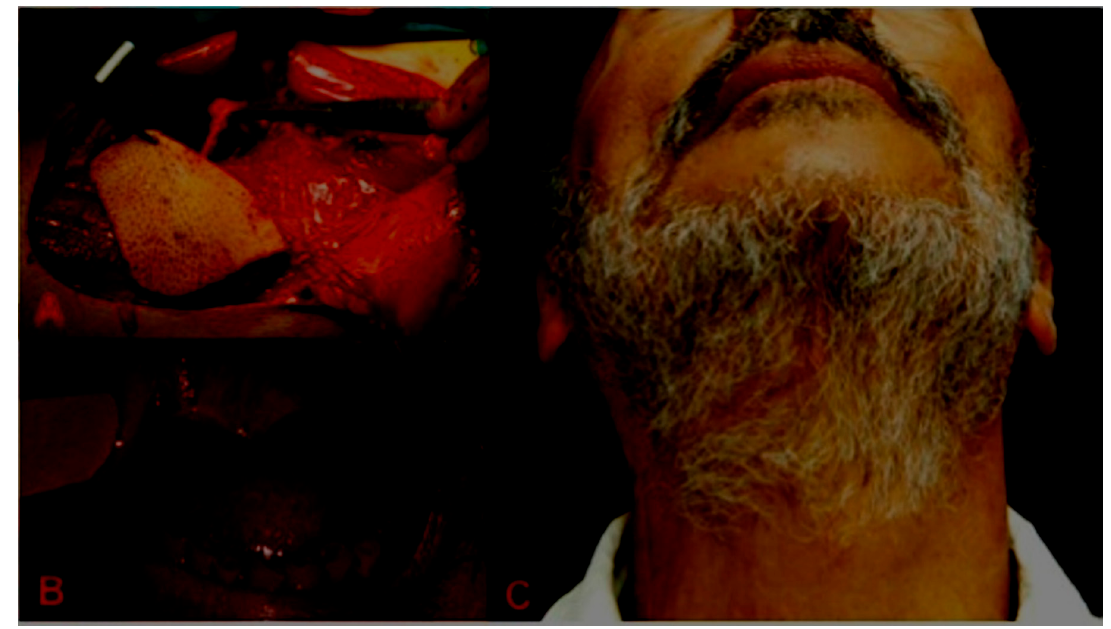
Figure 2. Case 1: ( A ) Intraoperative view of the ALT flap; ( B ) post-operative intraoral view (Free From Disease (FFD), 5 years after surgery); ( C ) post-operative axial view of the patient showing no scars on the chin and lip.